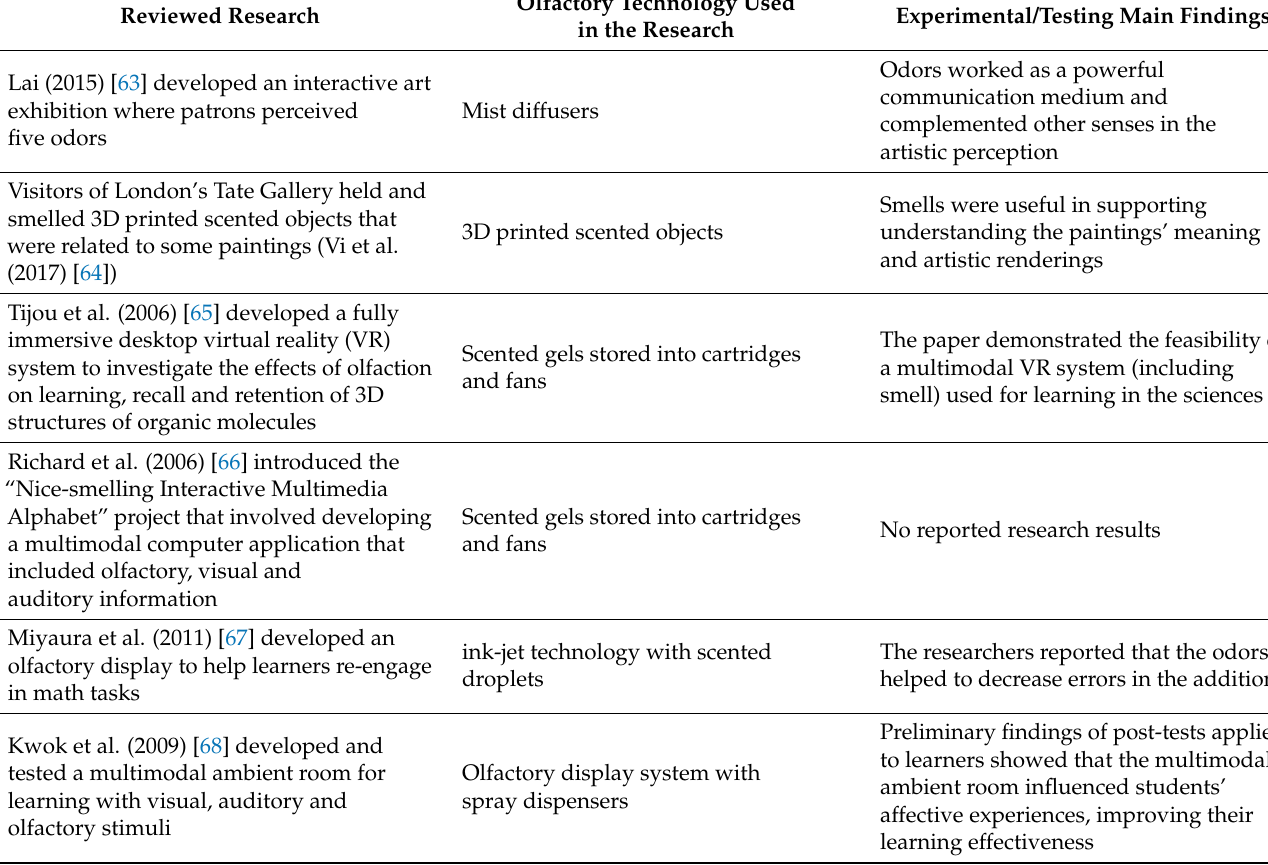
Table 1. A summary of research conducted on educational olfactory